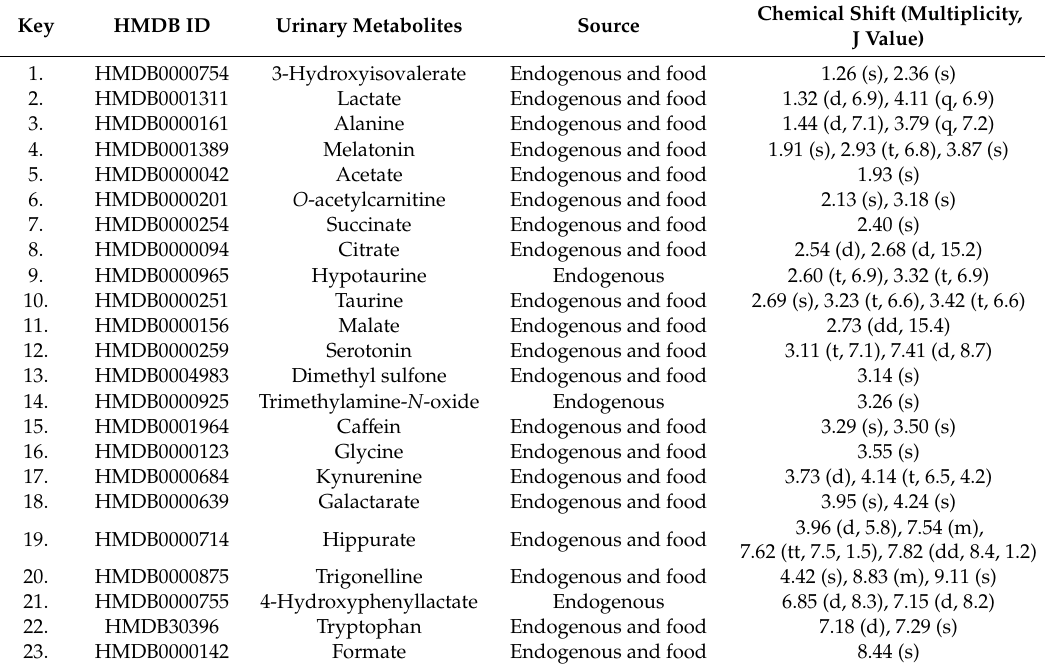
Table 2. 1H-nuclear magnetic resonance ( 1 H-NMR) data for the putative identified